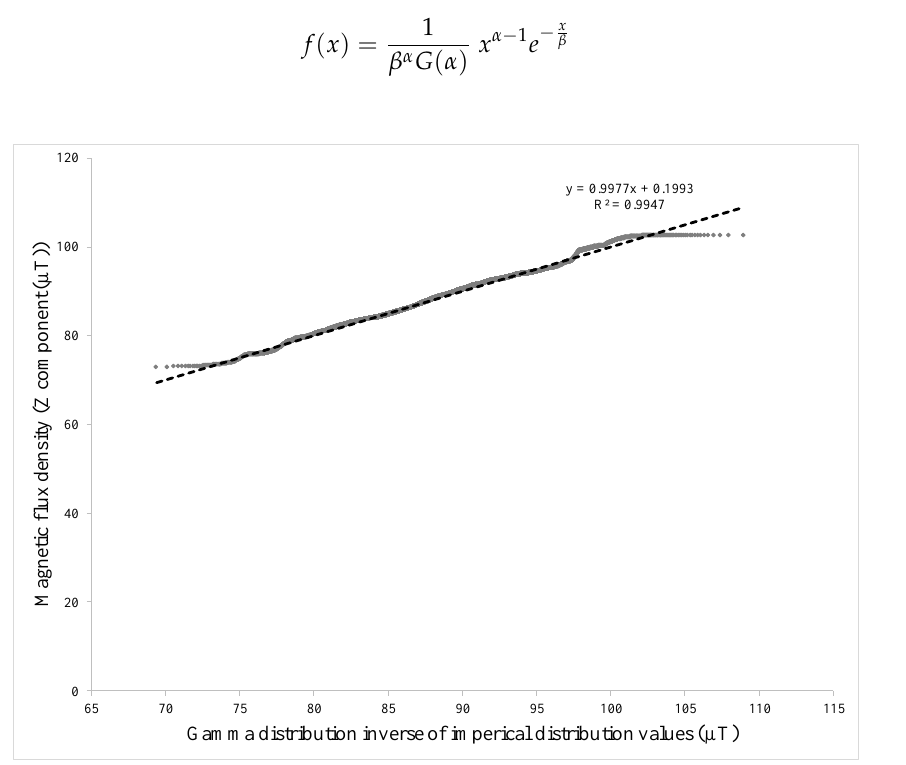
Figure 20. Probability plot for investigating the correlation of data with a gamma distribution.